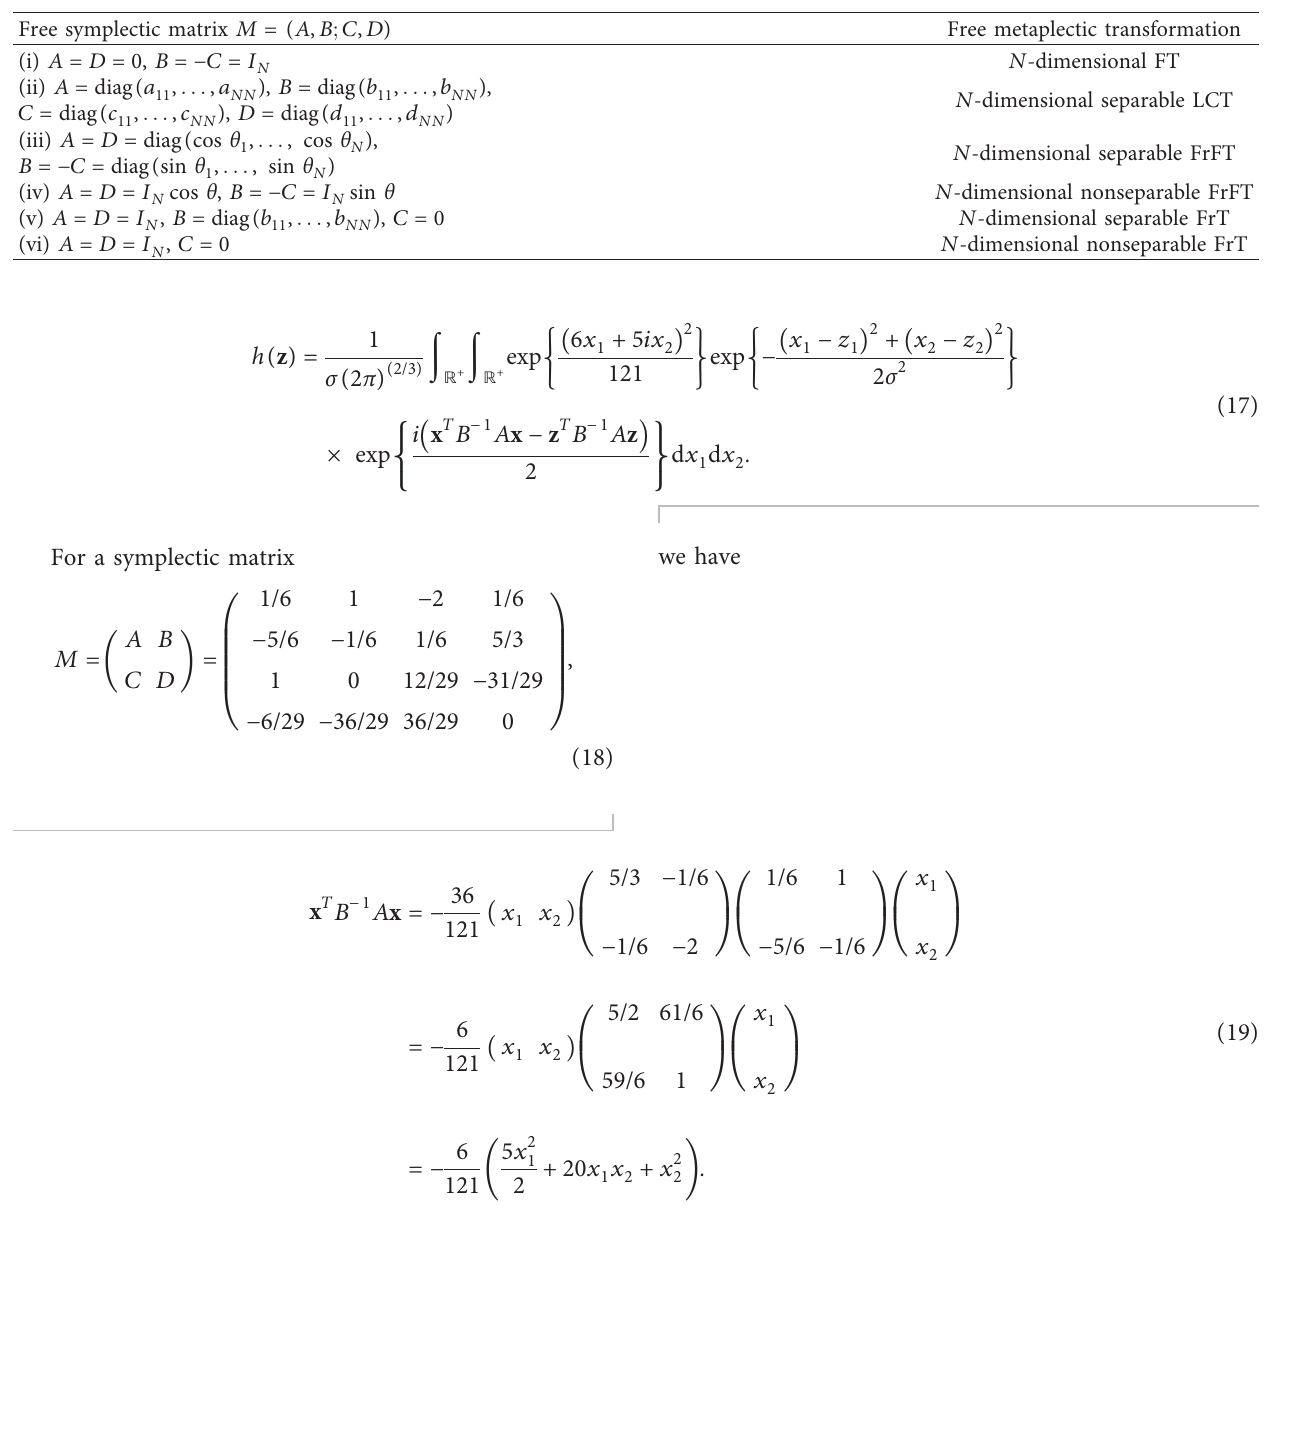
Table 1: Some special cases of the free metaplectic